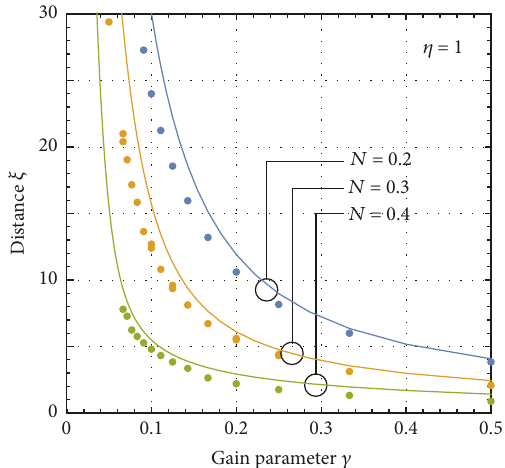
Figure 6: The distance until a first soliton appears ( 𝜉 B ) depends on the gain factor 𝛾 . Shown for 𝑁 = 0.2 (top trace) to 𝑁 = 0.4 (bottom trace) in increments. Solid, predictions; dots, numerical